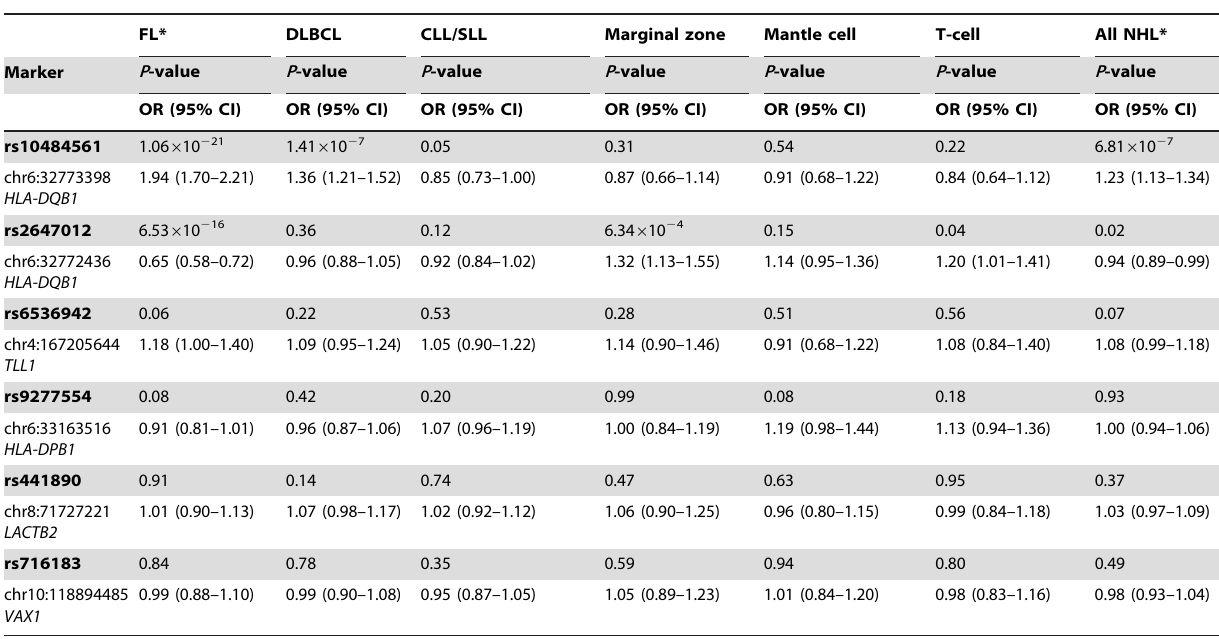
*Excluding SCALE1 for FL. OR: odds ratio, CI: confidence